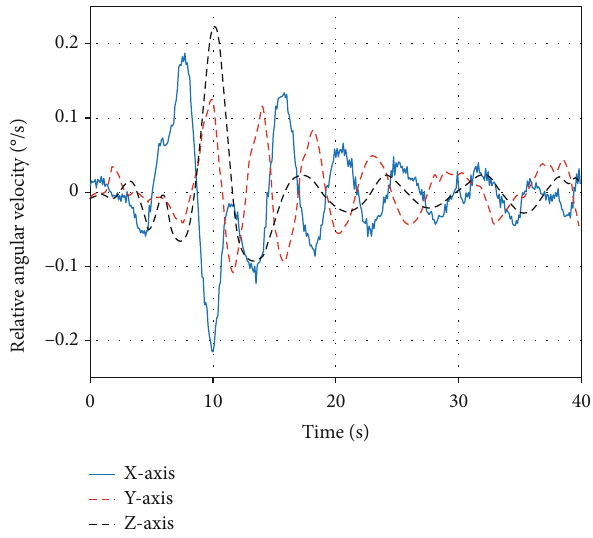
Figure 12: Relative angular velocity between two modules with compound